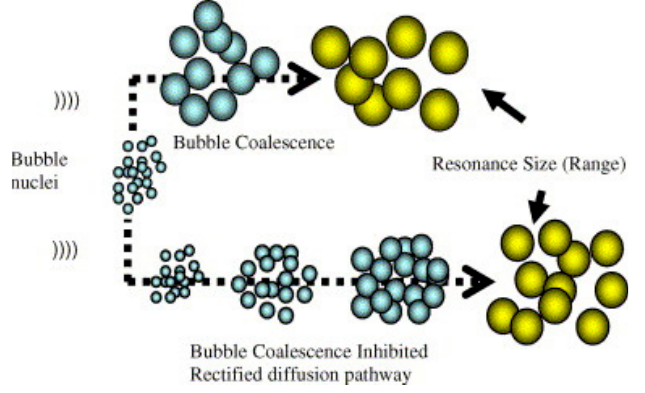
Figure 2. Schematic illustration of bubble nuclei growth in water through a pathway of rectified diffusion and coalescence under the influence of an ultrasonic field (adapted from Ashokkumar et al. [23] with permission from the publisher).